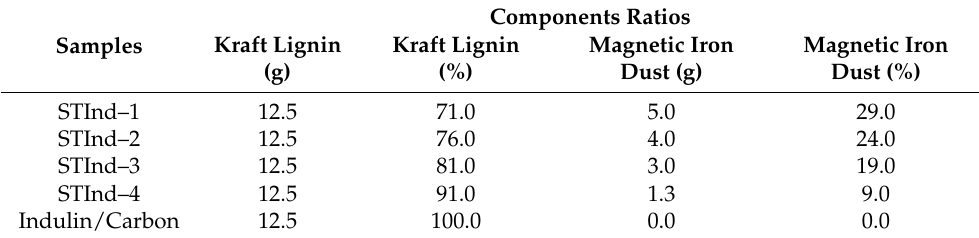
Table 1. The ratios of the initial components used to prepare